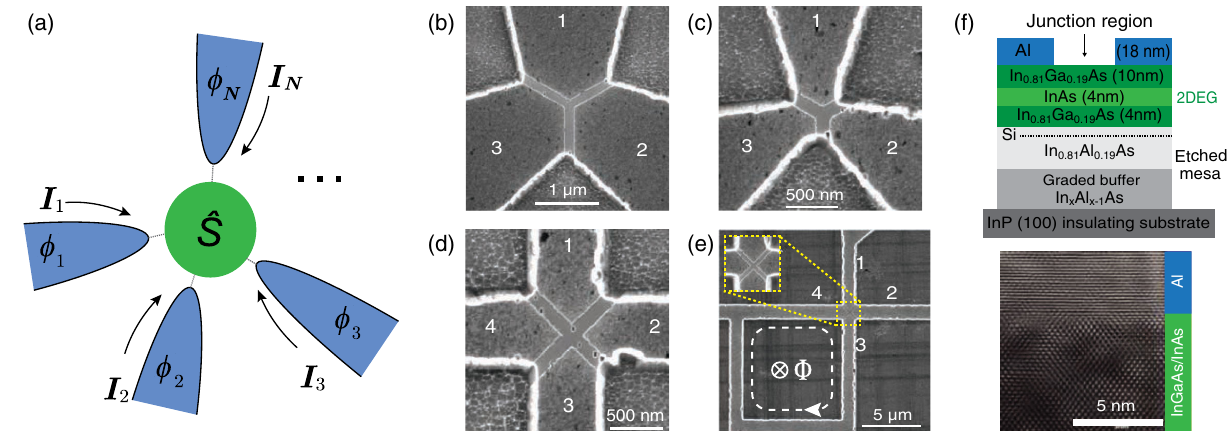
FIG. 1. Multiterminal Josephson junction. (a) A junction of N superconducting terminals (blue) across a normal scattering region ˆ S . Each terminal j ¼ 1 ; 2 ; … ; N has a superconducting phase ϕ (green), which is characterized by the scattering matrix supercurrent I . (b) – (e) SEM images of nanofabricated devices whose copies are used in this work. (b),(c) The N ¼ 3 case. (d) The j N ¼ 4 case. (e) The multi-SQUID, where terminals 3 and 4 are short-circuited by a superconductor and the loop is pierced by a magnetic flux Φ . (f) Junction ’ s schematic cross section revealing the material stack and composition of each layer of the heterostructure (top) along with a TEM image of the semiconductor-superconductor interface